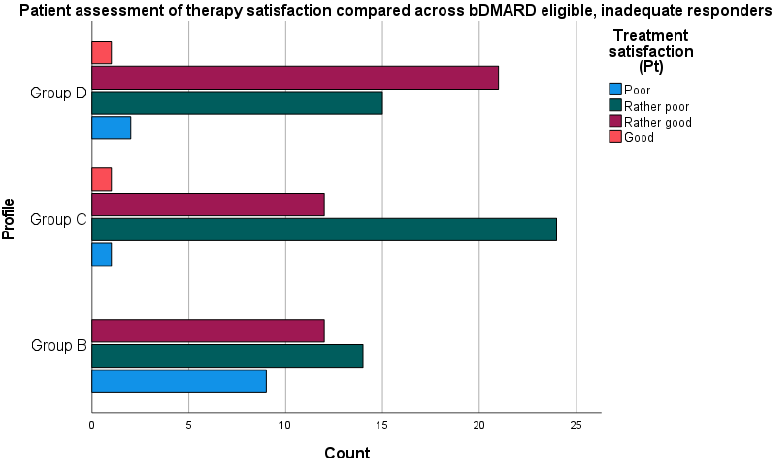
Figure 3. Overview of patient assessment of treatment satisfaction according to the question stem, “Are you satisfied with the treatment currently used, with regard to the lack of biological treatment of PsA under the drug program?”.